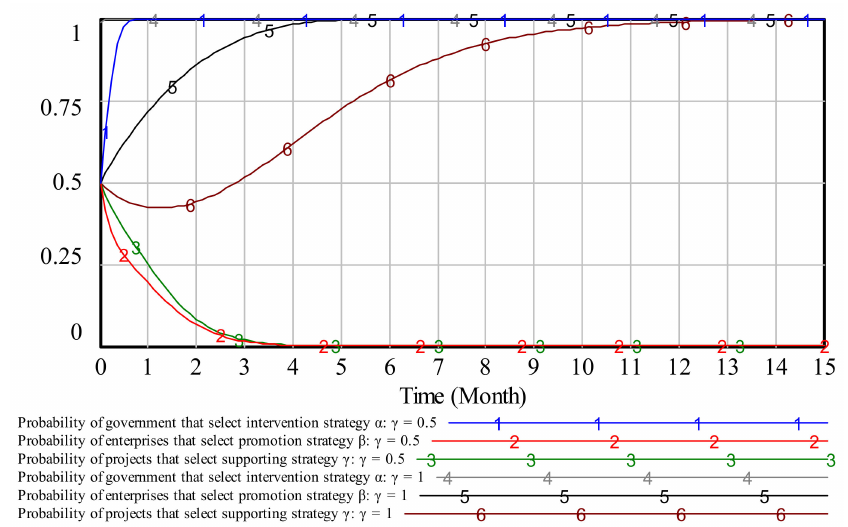
Figure 8. In BAU3, the evolution of enterprises and projects under government